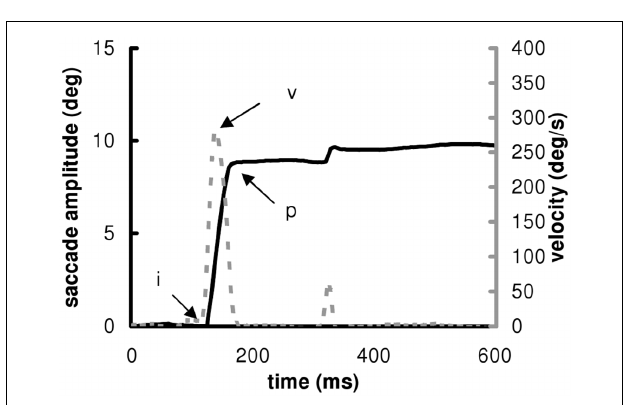
FIGURE 2 | Position (continuous) and velocity (discontinuous) traces of a saccade to the right to a target presented at 10. The markers “i” and “p” indicate the beginning and the end of the pulse component of the main saccade.The marker “v” indicates the maximum